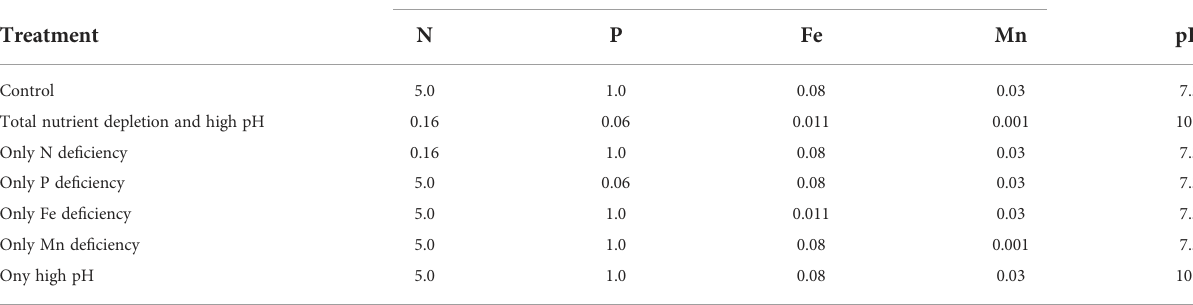
TABLE 1 Chemical composition of the culture medium in controls and in Ceratophyllum demersum treatments after 10 days (total nutrient depletion and high